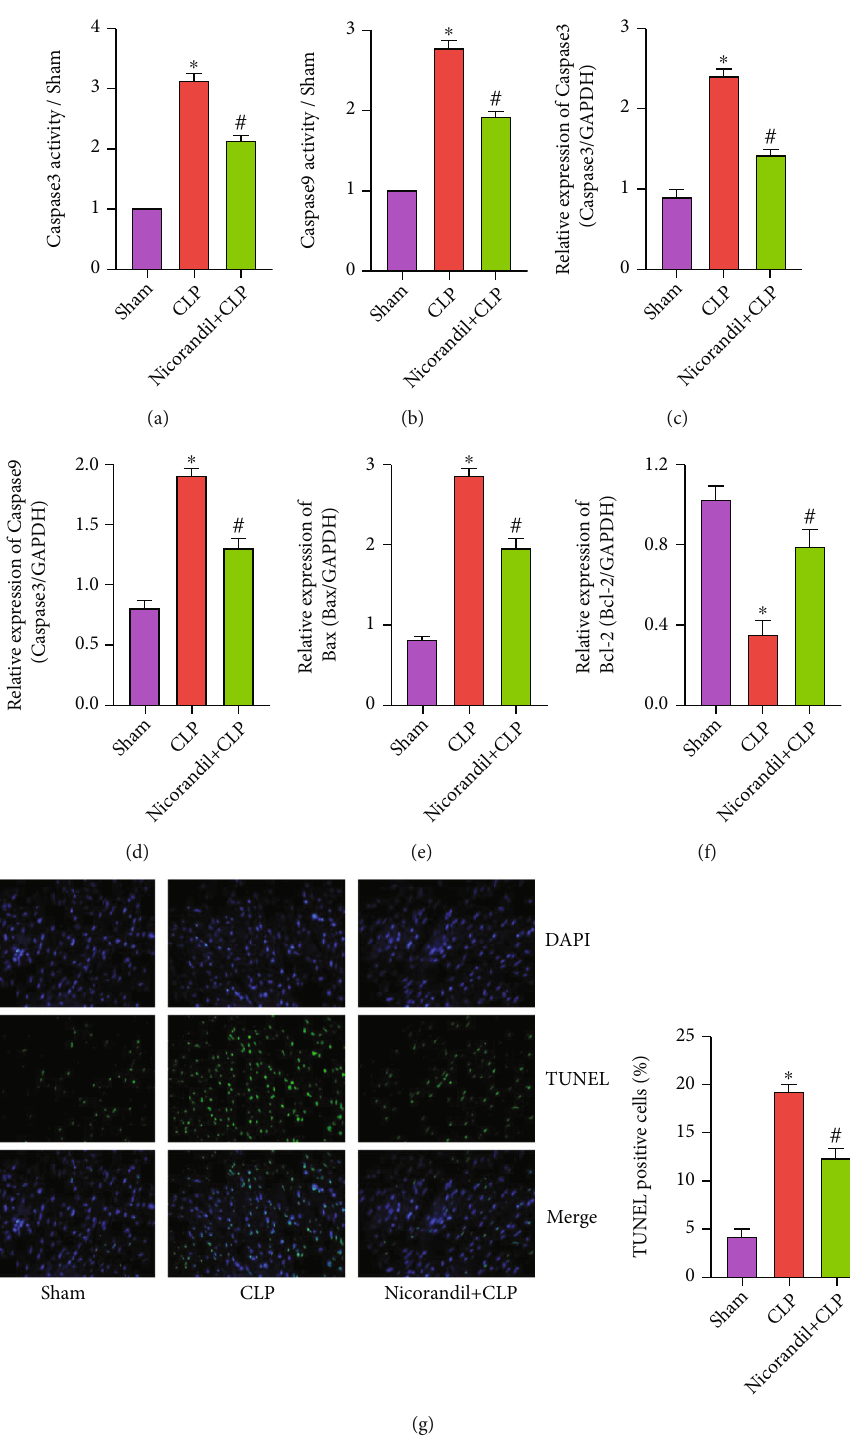
Figure 3: Nicorandil inhibits cardiomyocyte apoptosis in rats with septic cardiomyopathy. (a) The activity of Caspase3 in myocardial tissue of three groups of rats. (b) The activity of Caspase9 in myocardial tissue of three groups of rats. (c) The mRNA levels of Caspase3 in myocardial tissue of three groups of rats. (d) The mRNA levels of Caspase9 in myocardial tissue of three groups of rats. (e) The mRNA levels of Bax in myocardial tissue of three groups of rats. (f) The mRNA levels of Bcl-2 in myocardial tissue of three groups of rats. (g) TUNEL staining was used to detect myocardial apoptosis and statistical analysis. “ ∗ ” P < 0 : 05 vs. sham group; “ # ” P < 0 : 05 vs. CLP